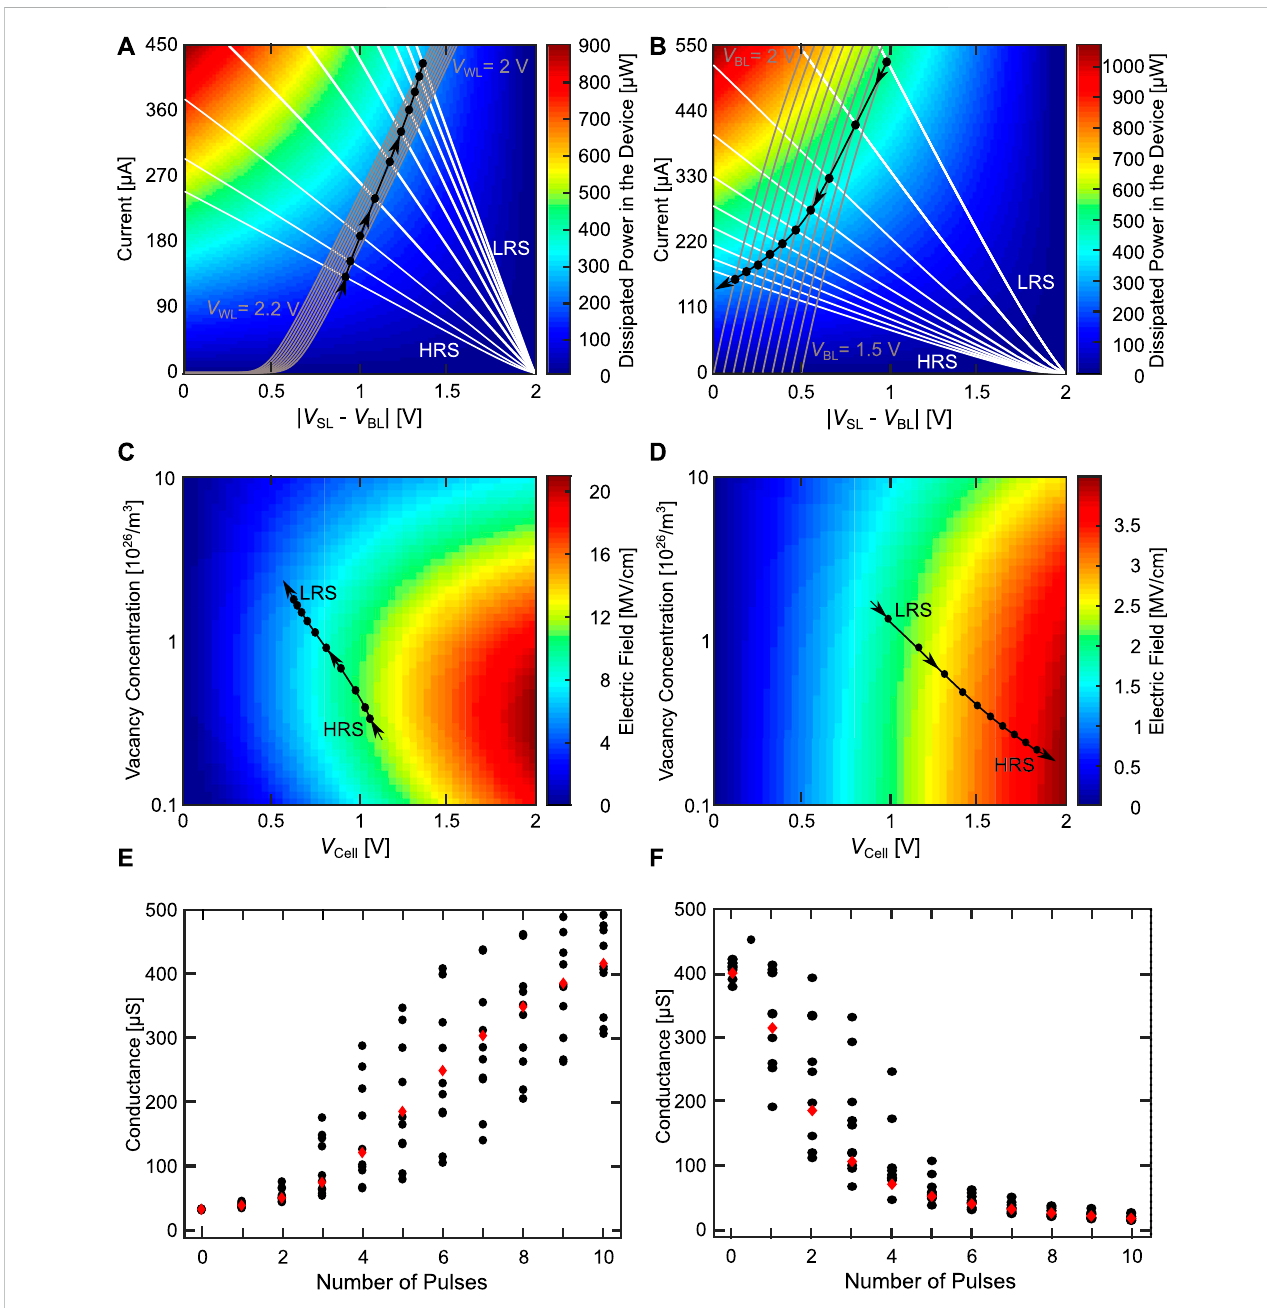
FIGURE 13 Con fi guration OE for the depression (A, C, E) and depression (B, D, F) direction. (A, B) shows the load line analysis for potentiation and depression direction, (C, D) show the development of the cell voltages driving the switching process. For (A, D) only the deterministic model parameters were used. In (E, F) the deterministic conductance evolution (red diamonds) is shown together with ten runs exhibiting d2d and c2c variability (black